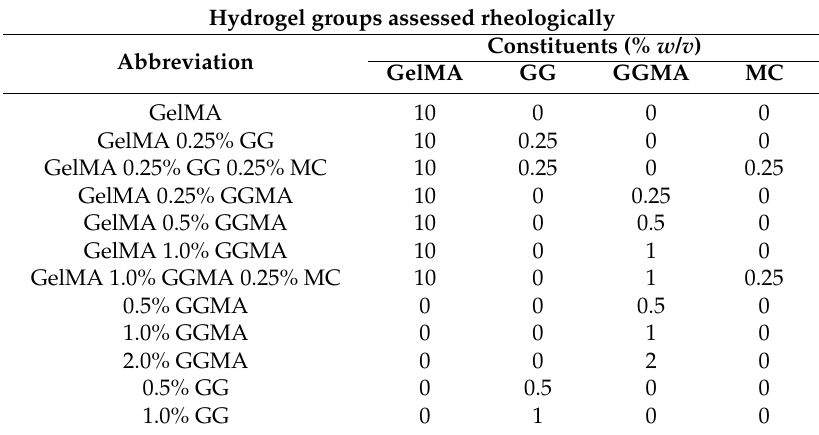
Table 1. Summary of hydrogel groups used for rheological characterization. GelMA =